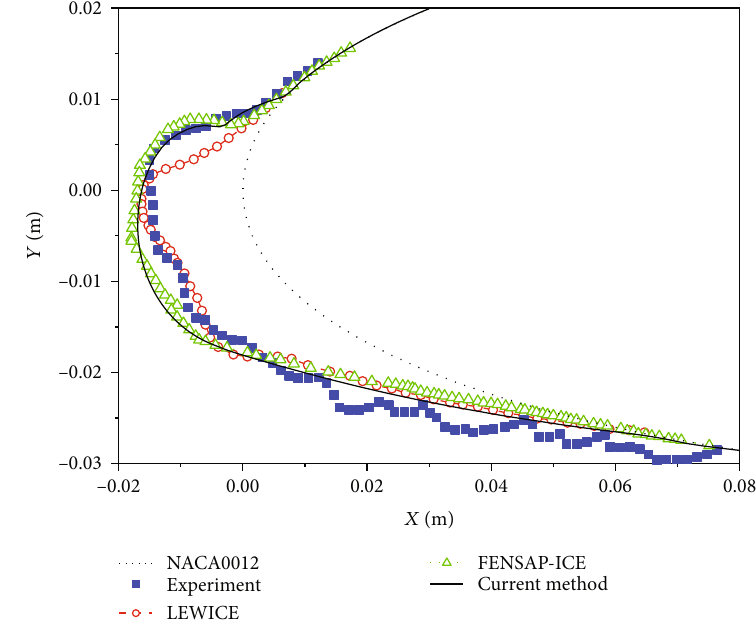
Figure 7: Comparison of rime ice accretion for the current numerical, LEWICE, FENSAP-ICE, and IRT experimental data.